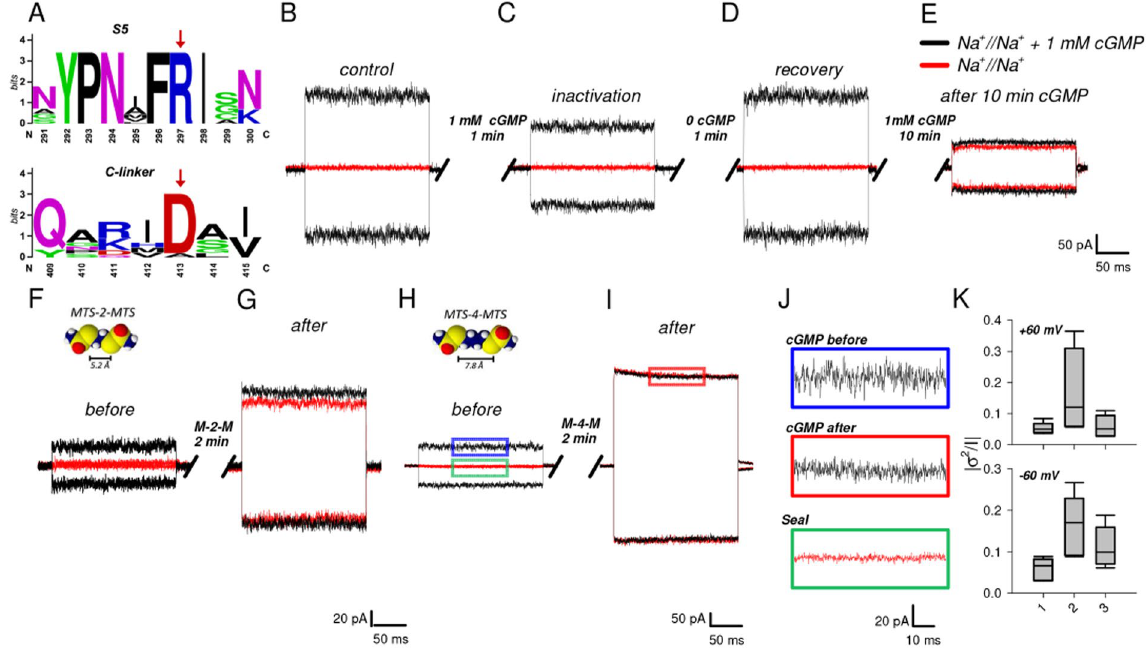
Figure 2. The double mutant channel D413C_R297C can be locked in the open state. ( A ) Web logo analysis of the sequence surrounding the conserved R297 and D413 residues (marked by an arrow). ( B – E ) Inactivation and locking in the open state of the double mutant channel D413C_R297C. in symmetrical Na + solution in the presence of 1 mM cGMP at ± 60 mV immediately after the membrane patch excision ( B ) and after 1 minute ( C ). The recovery ( D ) of the current after 1 minute in the closed state. Irreversible lock of the current in the open state ( E ) after a prolonged exposure to cGMP (10 minutes). ( F – G ) MTS-2-MTS locking effect in the open state. cGMP-activated currents immediately after the membrane patch excision ( F ) and after 2 minutes of 100 μ M MTS-2-MTS application in the open state ( G ). ( H – I ) As in (F) and ( G ), but in the presence of 100 μ M MTS-4- MTS. Red/black lines represent the current evoked by 0/1 mM cGMP. ( J ) Enlargements of boxes in ( H ) and ( I ). ( K ) Box plot summarize the quantitative noise analysis in the absence (1: n = 6 at + 60 mV and n = 6 at − 60 mV) and in the presence of 1 mM cGMP, before (2: n = 6 at + 60 mV and n = 6 at − 60 mV) and after (3: n = 6 at + 60 mV and n = 6 at − 60 mV) application of MTS-4-MTS. The horizontal line within each box indicates the median of the data; boxes show the twenty-fifth and seventy-fifth percentiles of the data; whiskers show the fifth and ninety-fifth percentiles of the